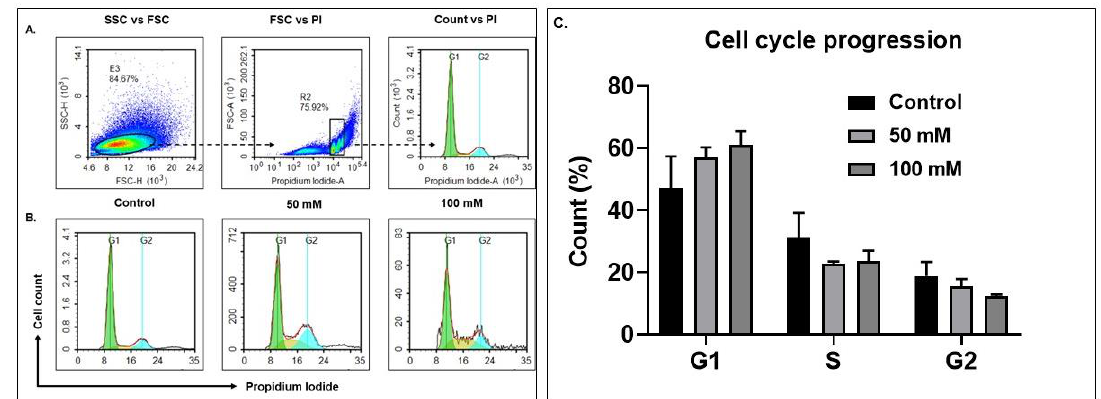
Figure 3. EtOH exposure modulate cell-cycle progression in BV-2 cell lines. For cell-cycle analysis at 72-h EtOH treatment, intracellular DNA was labeled with PI possessing a high affinity with DNA, and was used to detect DNA content during cell division. ( A ) Schematic representation (live cells were gated to exclude duplets cells (R2: 75.92%) and these cells were used to plot a cell-cycle histogram (count vs PI)). ( B ) Cell-cycle phases (G1, S and G2) post-exposure with 50 and 100 mM, and ( C ). Comparative histogram of the different phases of the cell cycle (Control, 50 and 100 mM).